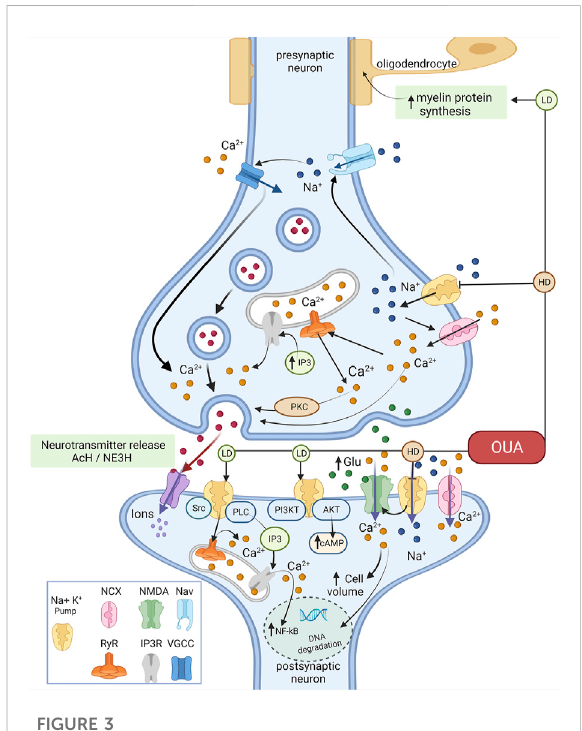
FIGURE 3 Representative schedule of the effects of ouabain on Ca 2+ signaling. Ouabain in high concentrations selectively binds to Na + / K + -ATPase, inhibiting its pump activity, leading to increased intracellular Na + and Ca 2+ concentrations. The latter by inducing a lower/reverse action of the Na + – Ca 2+ exchanger (NCX) colocalizes with the Na + /K + -ATPase. Ouabain effects on intracellular Ca 2+ in fl uence the release of acetylcholine (Ach) and norepinephrine (NE3H) and glutamate (Glu). Binding of ouabain to Na + /K + -ATPase triggers intracellular signaling networks in the glutamate signaling cascade through protein-protein interactions, generating many effects independent of the impairment of electrochemical gradients. In this case, ouabain (and other cardiotonic steroids) would act as an agonist, stimulating these pathways, acting in a different way observed as Na + /K + -ATPase inhibitor. In low concentrations ouabain can stimulate changes in Na + /K + -ATPase that triggers signaling complexes such PI3K-AKT pathways, increasing cAMP. Also, ouabain modulates Ca 2+ intracellular oscillation through activation of ryanodine receptor (RyR) and IP3 receptor (IP3R) that provoke the increasing of NF- κ B and activation of PKC. LD- Low Dose and HD- High dose (Figure were created with